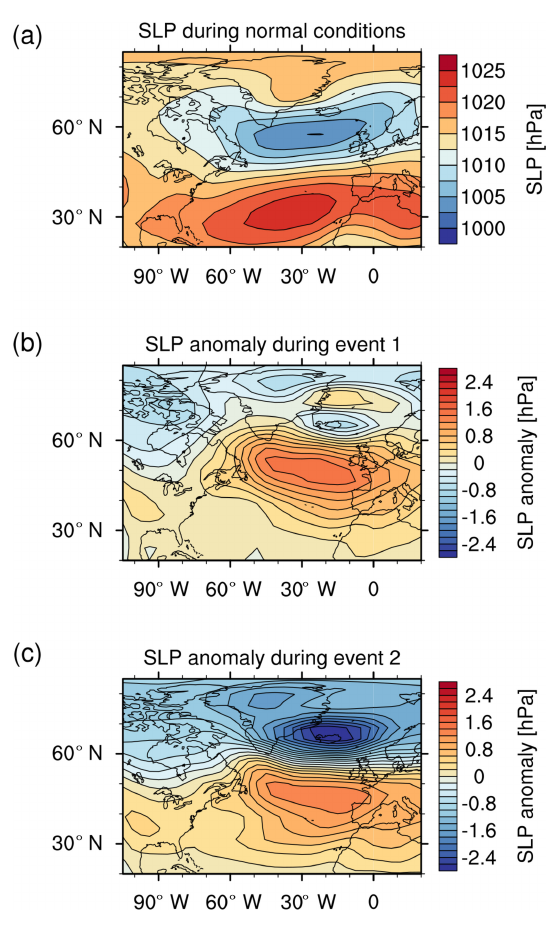
Figure 3. (a) Sea-level pressure during normal conditions (4000– 3201BP), sea-level pressure difference during (b) event 1 (4305– 4267BP), and (c) event 2